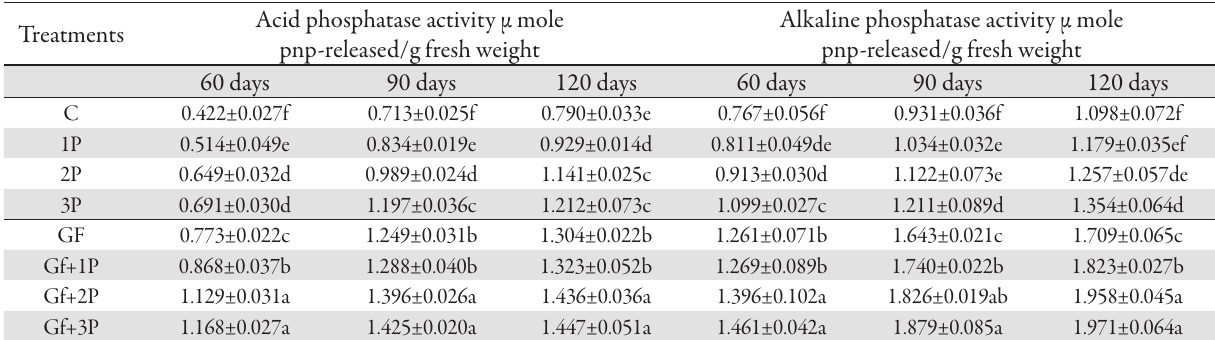
Tab. 3. Acid and alkaline phosphatase activity in Catharanthus roseus L. after 60, 90 and 120 days of AM inoculation under three different phosphate conditions